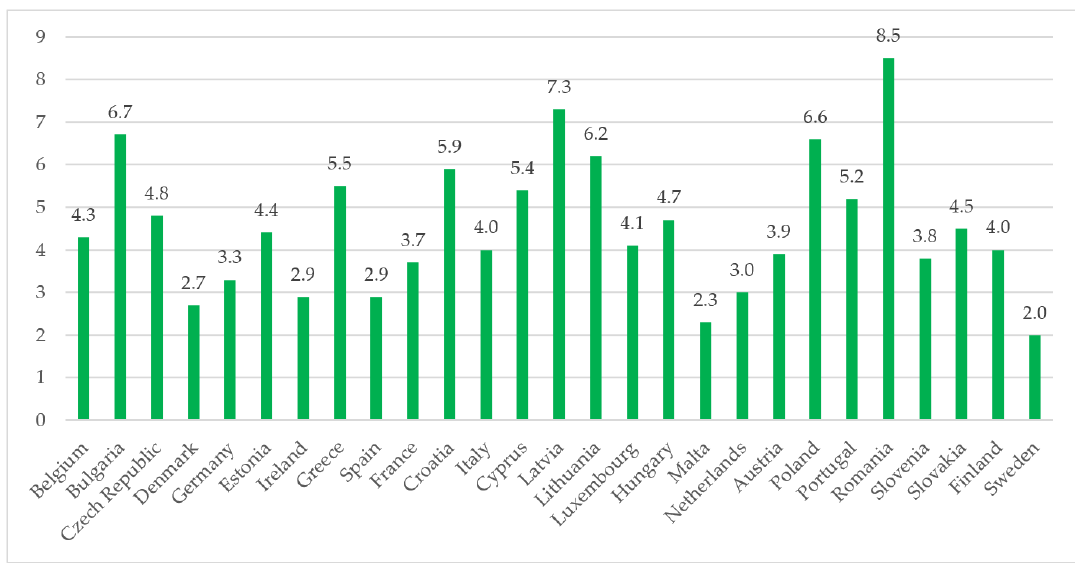
Figure 11. Road traffic deaths in EU countries in 2020, rate. Source: [74]. Appropriate and timely targeted investments and road maintenance that ensure